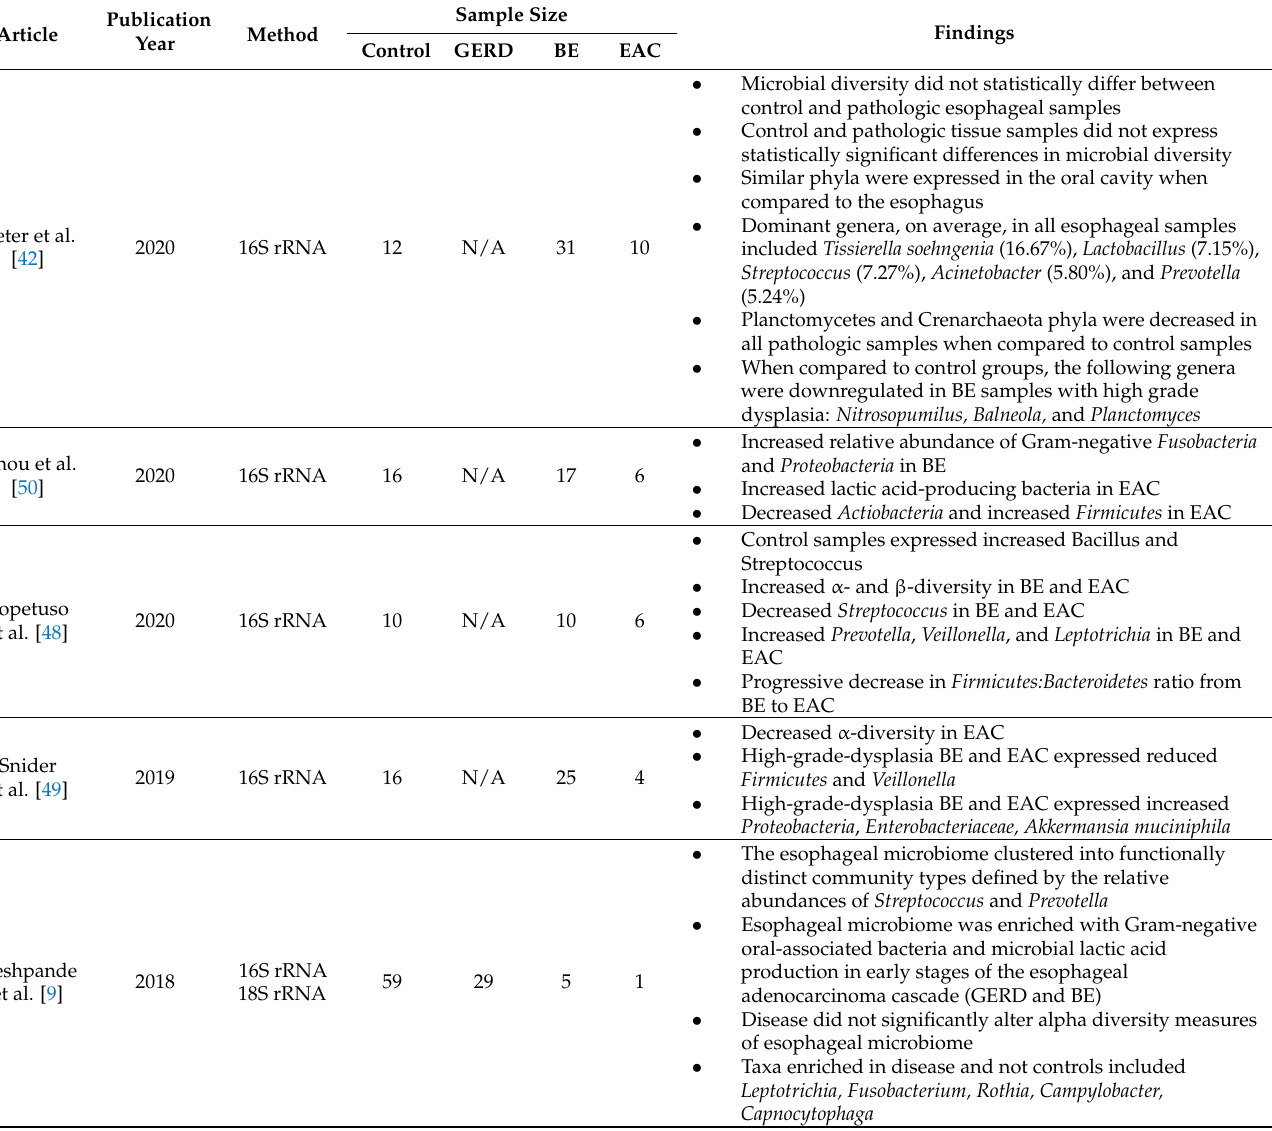
Table 2. Microbiota expressed by pathological